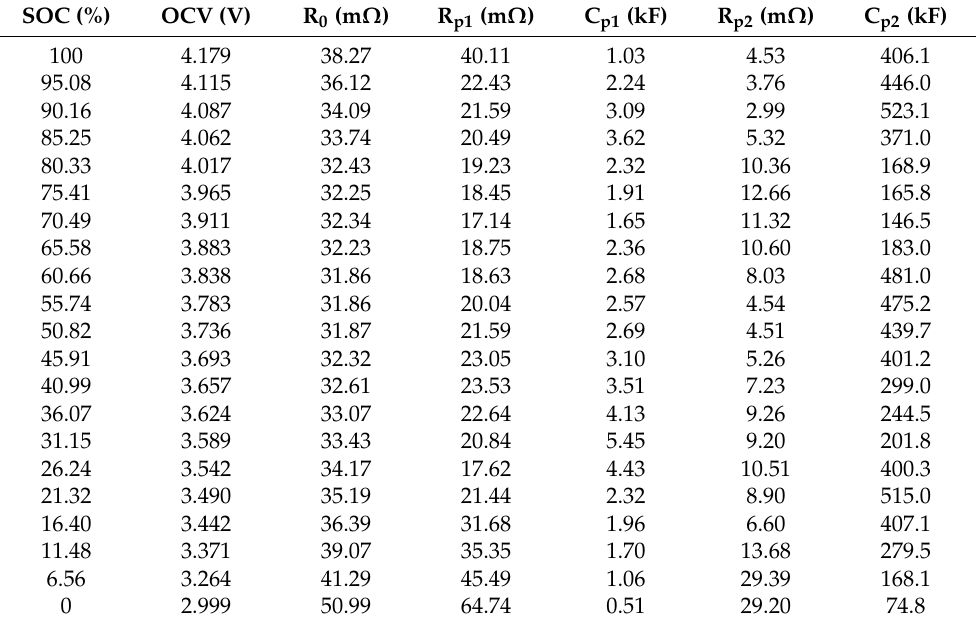
Table 1. The parameter identification